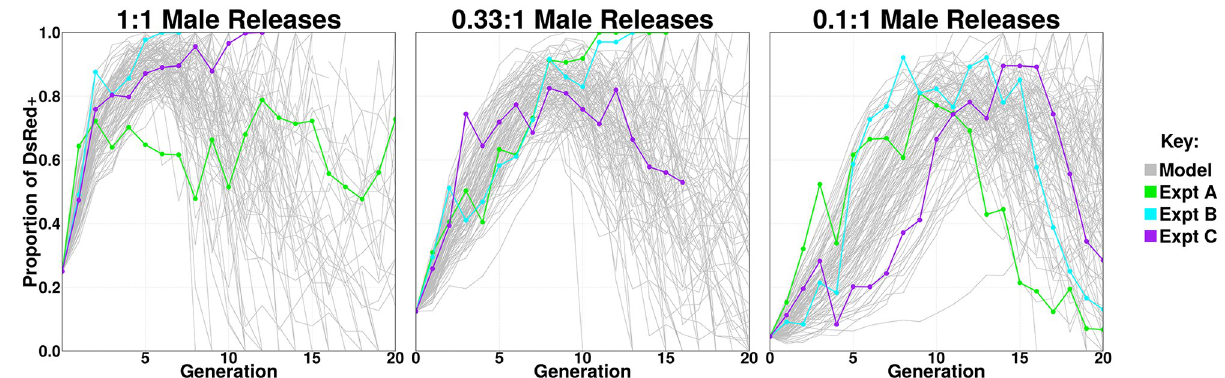
Fig 7. Observed and predicted dynamics with respect to the DsRed marker phenotype for non-overlapping experiments with the AsMCRkh2 gene drive system. Experimental data represent the triplicate replicates shown in Figs 3–5 and are displayed individually as green, blue and purple lines and connecting same-colored dots in each of the panels. Results from stochastic realizations of the fitted model (depicted in S2–S5 Files) are shown as thin grey lines (100 simulations per release ratio). Cages were set up with wild-type females and appropriate males to achieve 1:1, 0.33:1 and 0.1:1 (left, middle and right panels, respectively) transgenic gene-drive male release ratios. DsRed + phenotype frequencies were monitored over 20 generations for the 1:1 and 0.1:1 releases, and over 17 generations for the 0.33:1 releases. The X-axis is the generation number after initial introduction and the Y-axis is the proportion of mosquitoes showing the DsRed marker phenotype (DsRed + ). The DsRed + phenotype results from having at least one copy of the gene-drive allele and hence reflects the spread of the gene drive system, sometimes to full introduction for 1:1 and 0.33:1 releases. The stochastic model captures the variability inherent in the experimental process and reflects the dual possibilities of gene drive full introduction and population reversion to a wild-type/drive-resistant state.